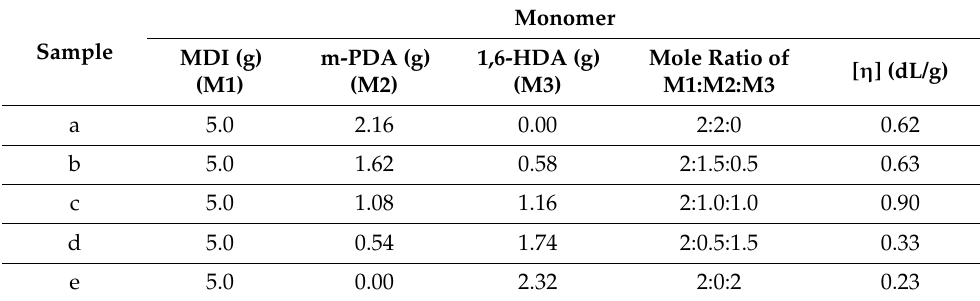
Table 1. Monomer compositions and the intrinsic viscosity of the polyurea samples. From reference [42].